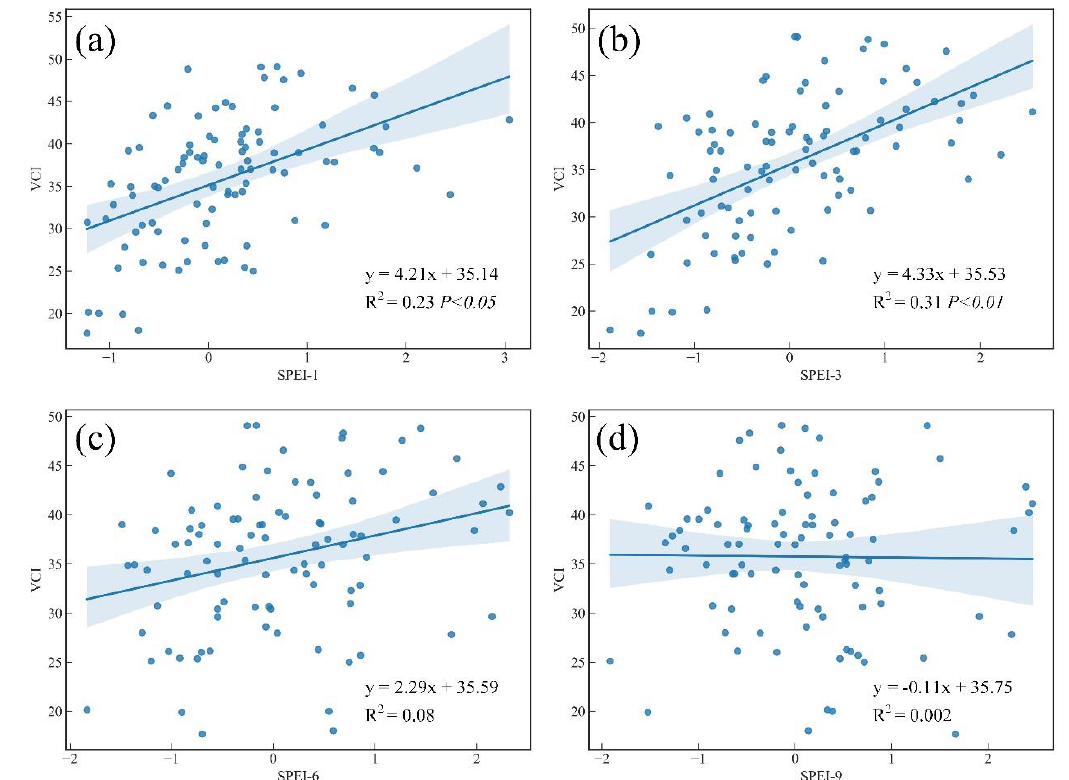
Figure 9. Correlation between VCI and SPEI during winter wheat growth in Henan Province from 2001 to 2015 at ( a ) 1, ( b ) 3, ( c ) 6, and ( d ) 9 months.